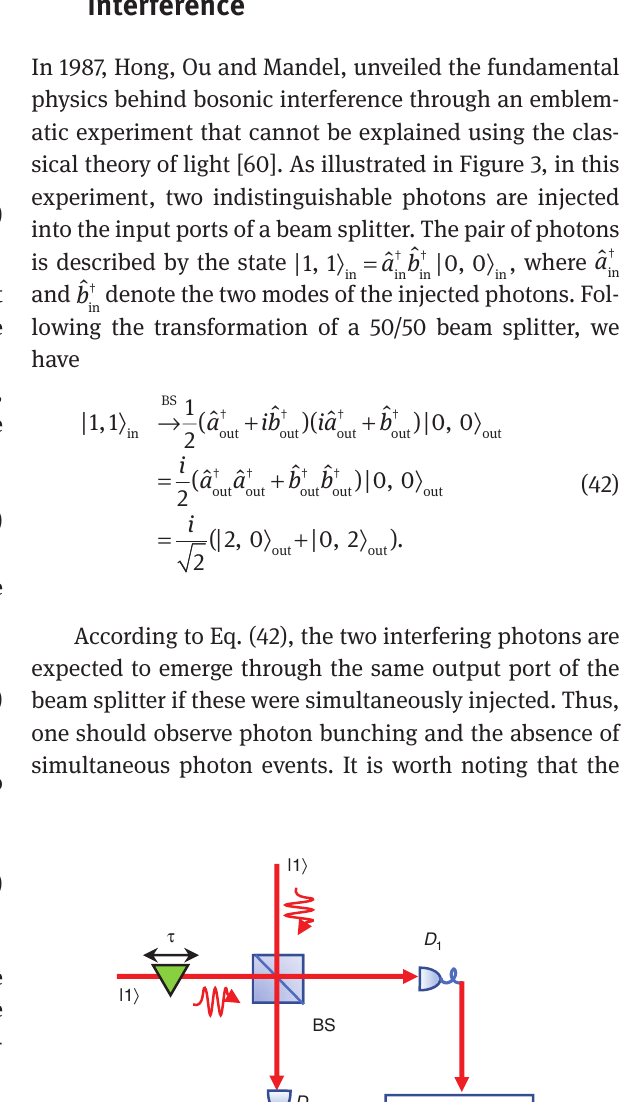
and D . The time delay 1 2